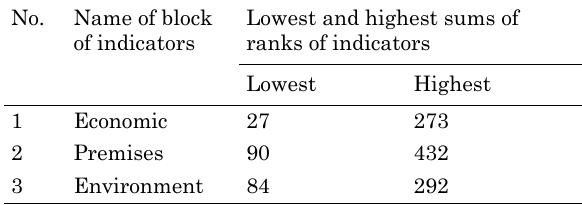
table 6. lowest and highest sums of the ranks for the commercial real estate (office) lease